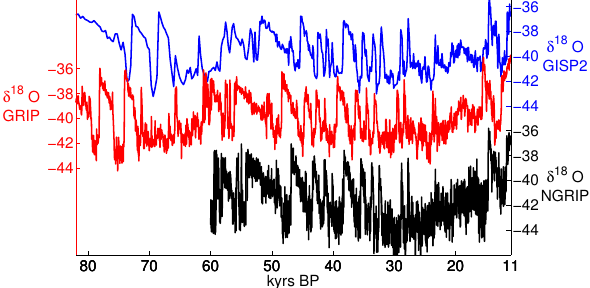
Fig. 1: ( δ 18 O) from NGRIP, GRIP and GISP2 expressed in ‰ with respect to Vienna Standard Mean Ocean Water us- ing GICC05, ss09sea and Meese/Sowers time scales respec-